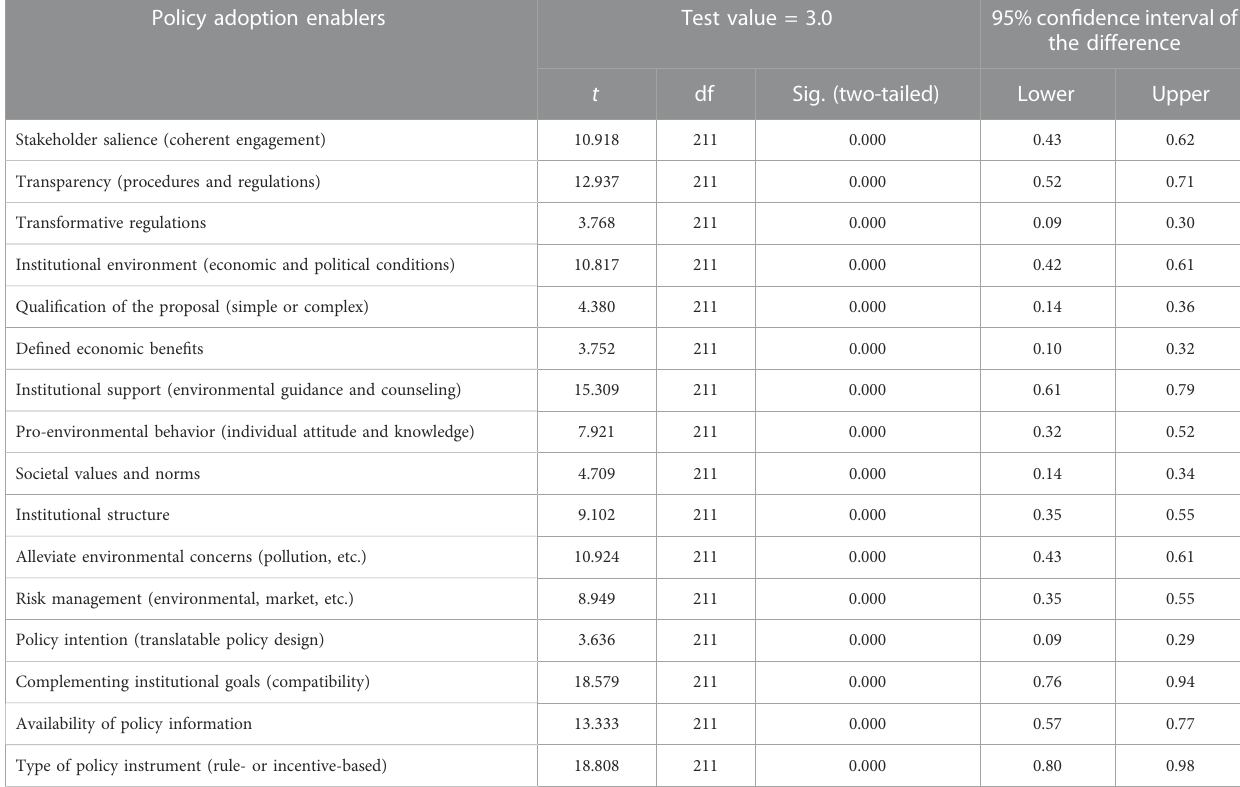
TABLE 4 Statistical results of one-sample t -test. Policy adoption